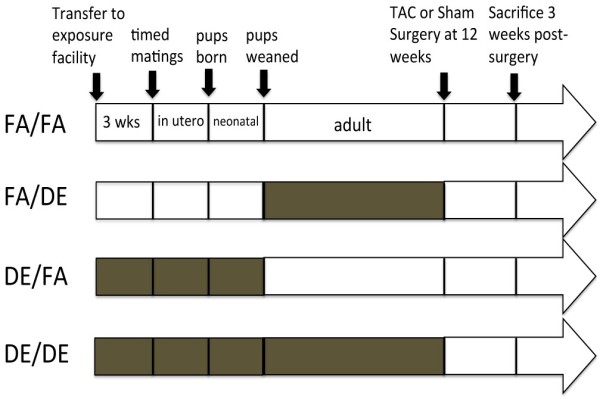
Schematic diagram indicating diesel exhaust (DE) exposure paradigm. Four exposure groups tested the effect of developmental or adult exposure to DE or filtered air (FA) exposures on adult cardiac function. Brown color in horizontal arrows represents DE exposure (300 μg/m3, 6 hours per day, 5 days per week), while white color represents FA exposure.